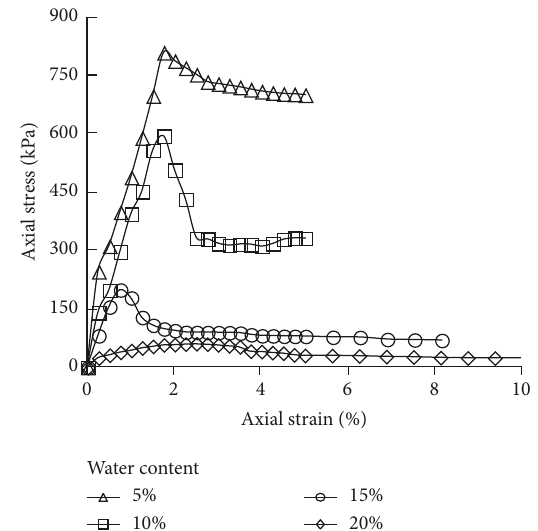
Figure 6: Stress-strain curves of intact loess under different water